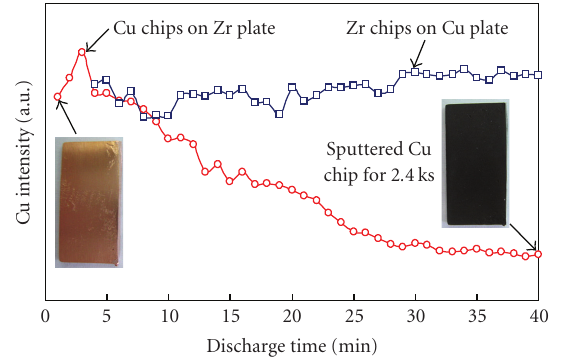
Figure 5: Changes of Cu intensity in spectral di ff raction of Cu-Zr sputtered films on discharge time in sputtering when using Cu chips on Zr plate and Zr chips on Cu plate composite targets.